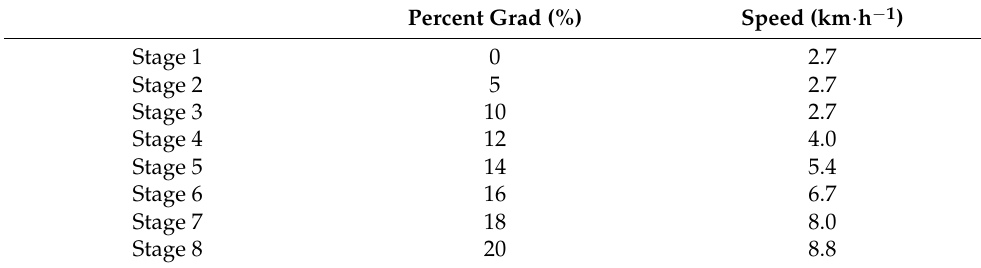
Table 1. The modified Bruce protocol (modification of the original protocol of Bruce